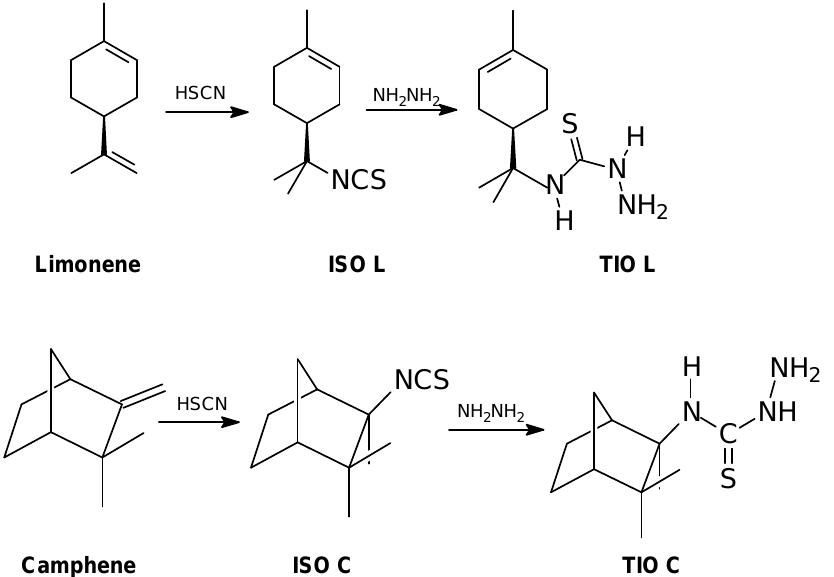
Scheme 1 . Synthetic routes for the thiosemicarbazides TIO L and TIO